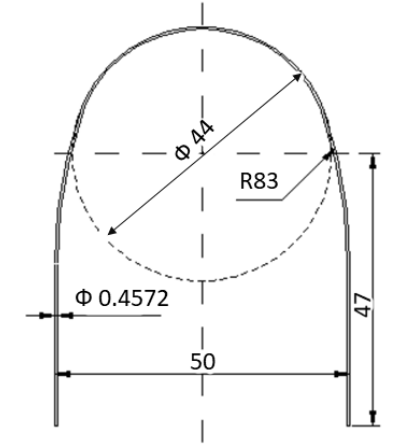
Figure 1. Geometry of the orthodontic archwires studied. The measuremts are in millimeters.